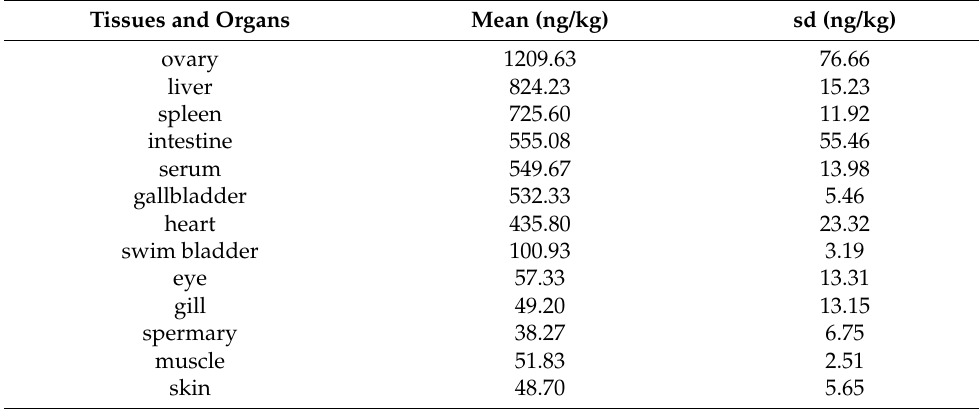
Table 5. Concentrations of TTX in 13 tissues and organs of puffer